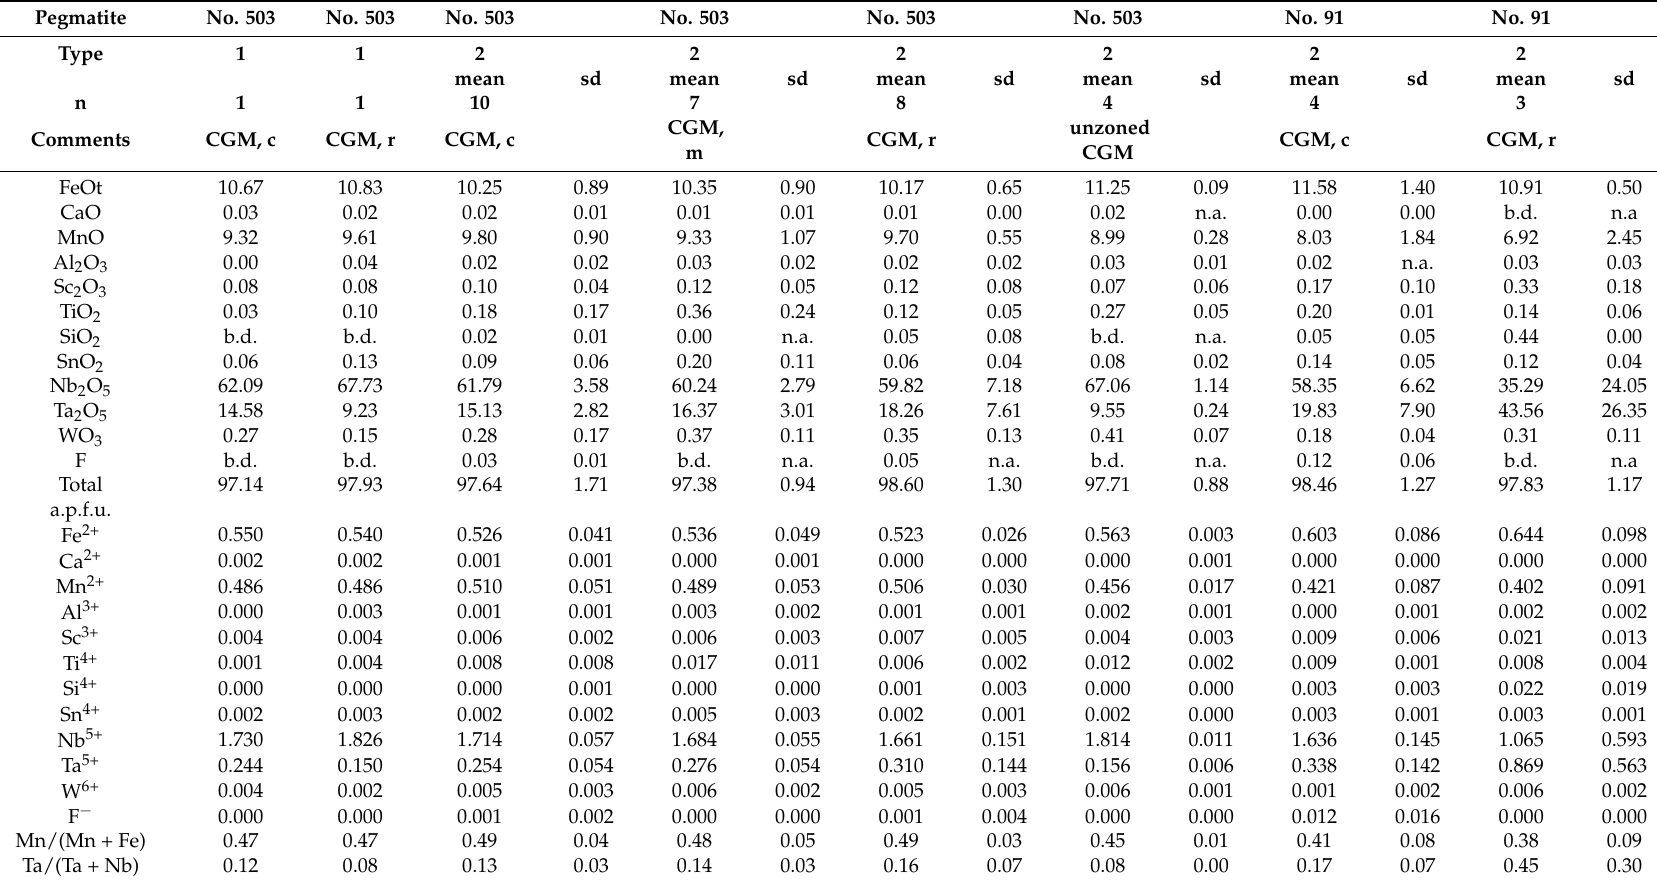
Table 1. Chemical composition (wt. % oxides and a.p.f.u.) of CGM and ferrowodginite in the Dahongliutan albite-spodumene